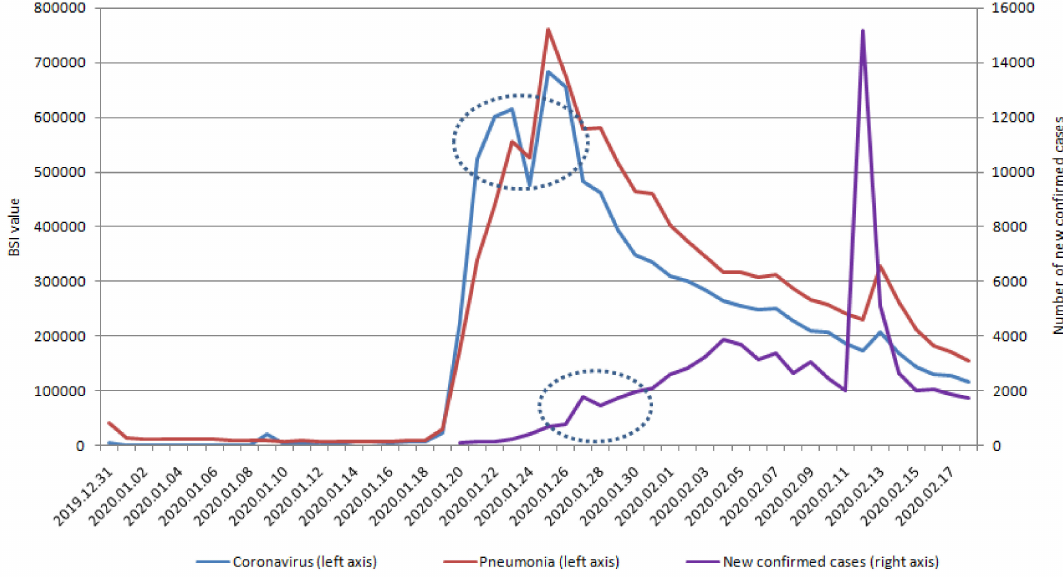
Figure 5. New confirmed COVID-19 and lag days of coronavirus and